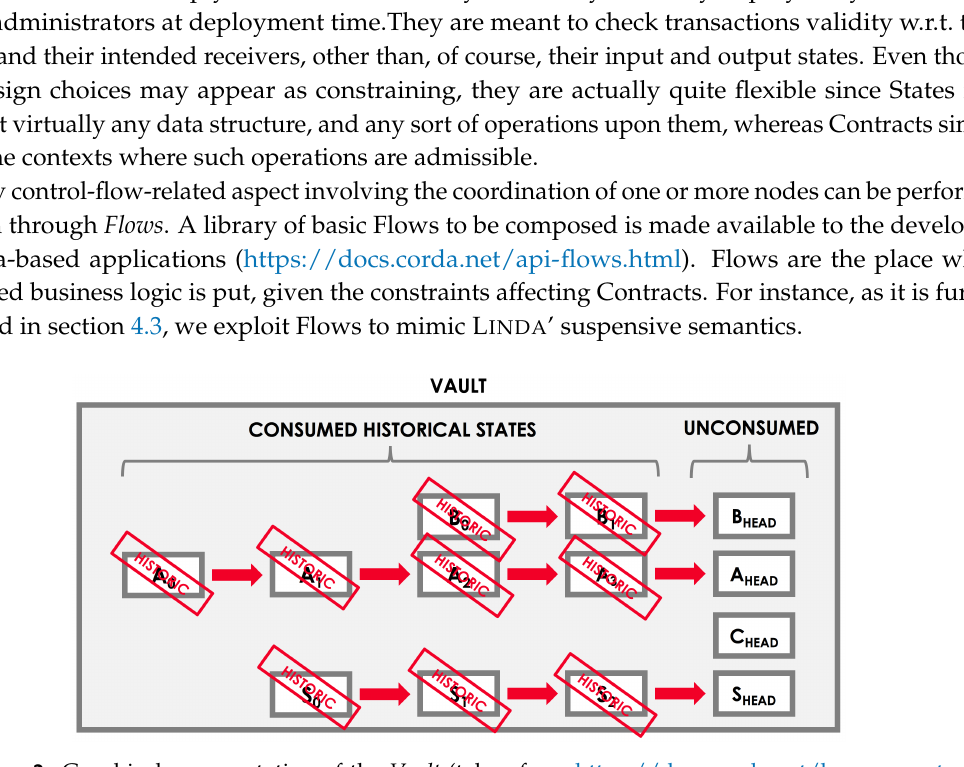
Figure 2. Graphical representation of the Vault (taken from https://docs.corda.net/key-concepts-